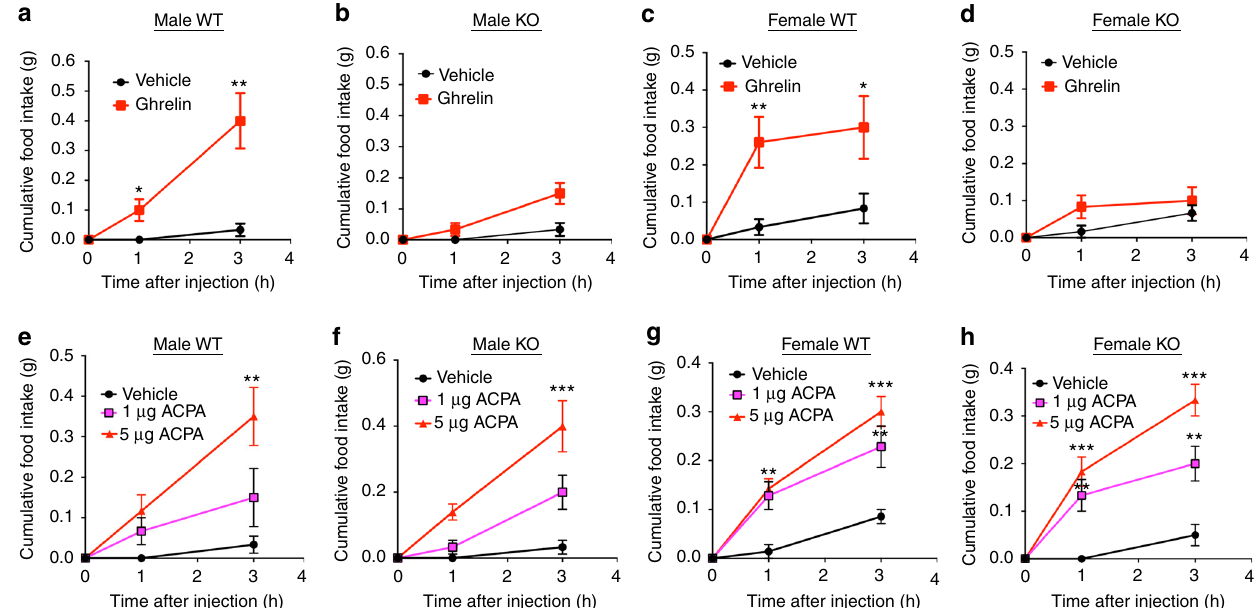
Fig. 7 MRAP2 is necessary for ghrelin to induce food intake. a , b Food intake in satiated male WT ( a ) and Mrap2 KO ( b ) mice after ICV injection of saline or 13.25 µ g ghrelin ( n = 6). c , d Food intake in satiated female WT ( c ) and Mrap2 KO ( d ) mice after ICV injection of saline or 13.25 µ g ghrelin ( n = 6). e , f Food intake in satiated male WT ( e ) and Mrap2 KO ( f ) mice after ICV injection of saline or 1 or 5 μ g of the CB1R agonist ACPA ( n = 5/group). g , h Food intake in satiated female WT ( g ) and Mrap2 KO ( h ) mice after ICV injection of saline or 1 or 5 μ g of the CB1R agonist ACPA ( n = 5/group). Error bars are SEM. ** p < 0.01, *** p <